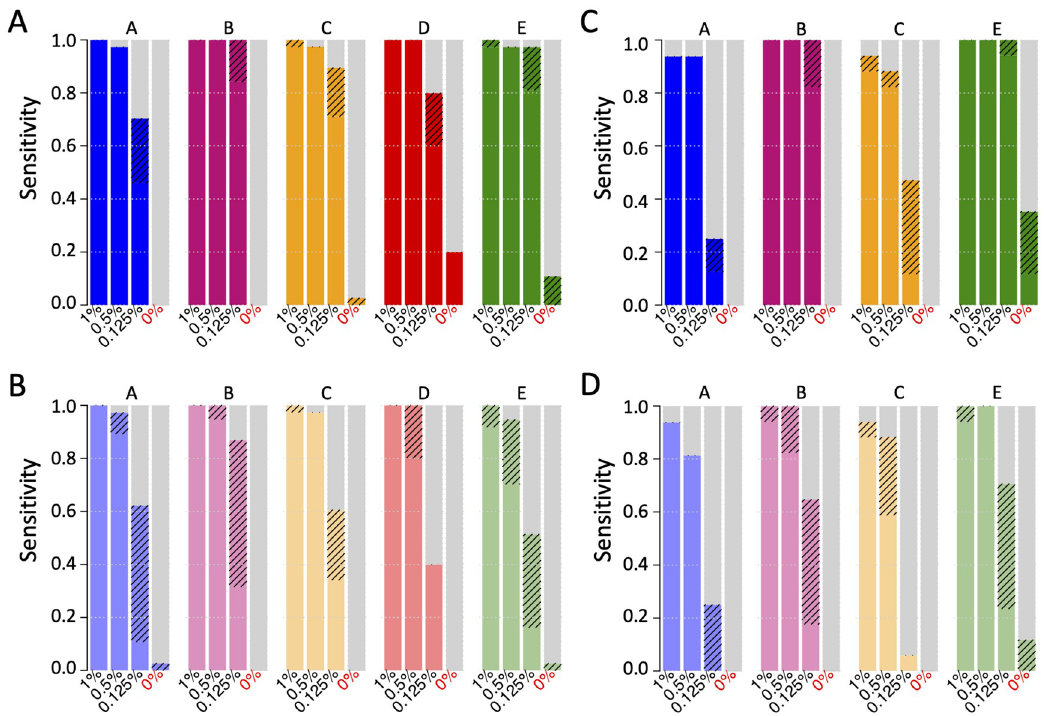
Fig 2. Analytical sensitivity and reproducibility. Solid bar: fraction of the reference mutations detected in both replicates; striped bar: fraction of the reference mutations detected in one of the two replicates; x-axis, VAF of the reference mutations; y-axis, detection sensitivity. A, Detection sensitivity (sum of solid and striped bar) and reproducibility (solid bar only) of each assay for sample set one at 0 to 1% VAF and input of 30 ng (assay A and B) or 50 ng (assay C, D, E). Assay B (purple) and assay E (green) detected 95–100% of the reference mutations at 0.125% VAF; B, Similar analysis for sample set one with 10 ng DNA input. Assay B (light purple) showed the highest sensitivity of 85%. C, Similar analysis for sample set two with input of 30 ng (assay A and B) or 50 ng (assay C, D, E). Assay B (purple) and assay E (green) exhibited 100% detection of the mutations at 0.125% VAF. D, Similar analysis for sample set two with 10ng DNA input. Assay B (light purple) achieved the highest detection sensitivity of 65% among the five